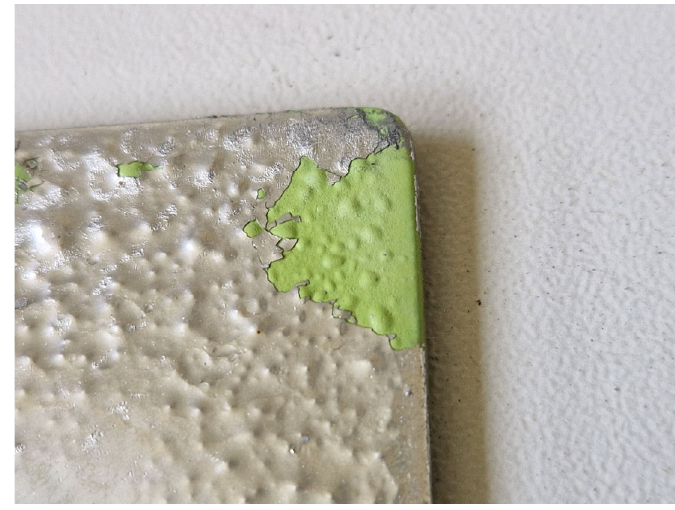
Figure 14. Sample 8 and its fatal damage.